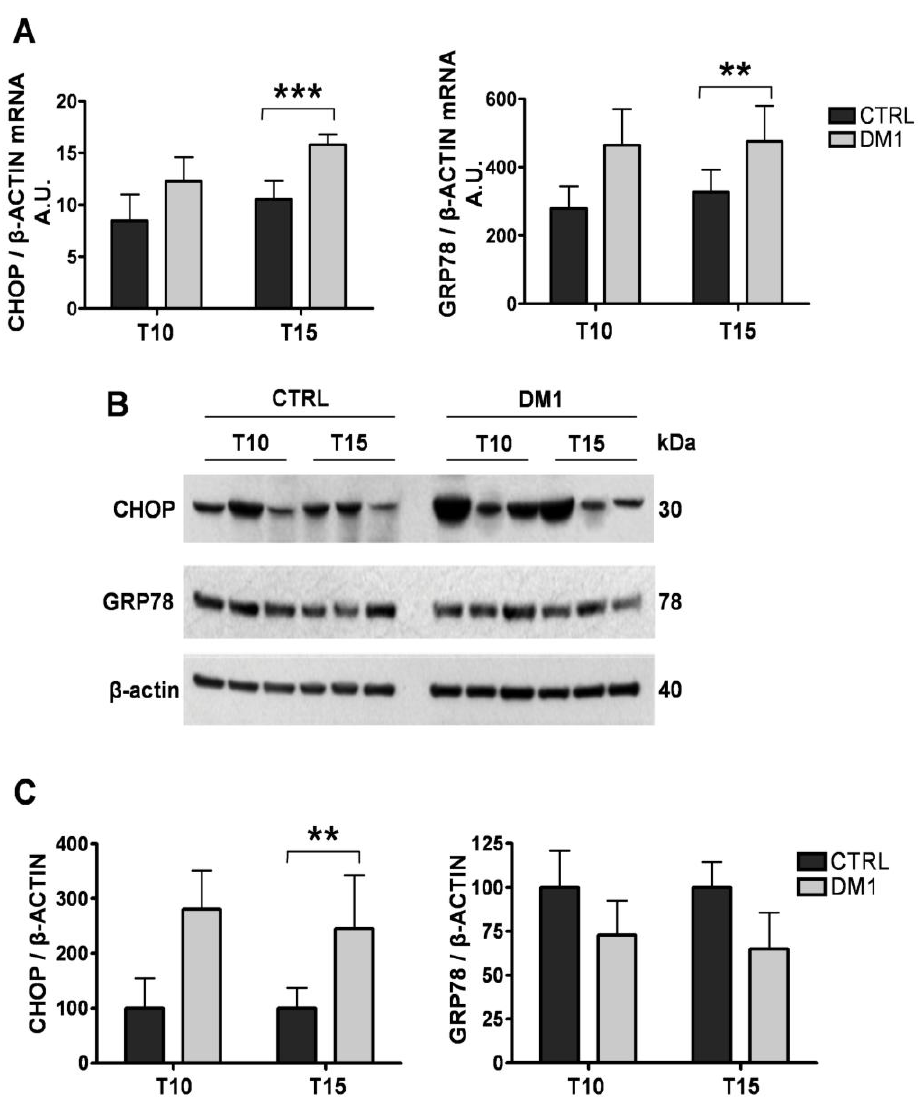
Figure 5. Characterization of the ER stress response in control and DM1 myotubes at 10 (T10) and 15 (T15) days of differentiation. ( A ) Expression levels of CHOP and GRP78 mRNA of control and DM1 myotubes at 10 and 15 days of differentiation as measured by quantitative RT-PCR. ( B ) Representative Western blot of CHOP and GRP78 from control and DM1 myotubes at 10 and 15 days of differentiation. ( C ) Quantification of CHOP and GRP78 protein levels, normalized (cid:87)(cid:82)(cid:3) (cid:533) -actin. The values represent the ratio of band intensities and are given in arbitrary units (A.U.) Data are expressed as mean ± SD of a single experiment of RT-PCR carried out in triplicate ( A ) and as mean ± ES of two experiments for WB ( C ). * p < 0.05, *** p < 0.001 as compared (cid:87)(cid:82)(cid:3)(cid:70)(cid:82)(cid:81)(cid:87)(cid:85)(cid:82)(cid:79)(cid:86)(cid:3)(cid:69)(cid:92)(cid:3)(cid:54)(cid:87)(cid:88)(cid:71)(cid:72)(cid:81)(cid:87)(cid:86)(cid:182)(cid:3) t